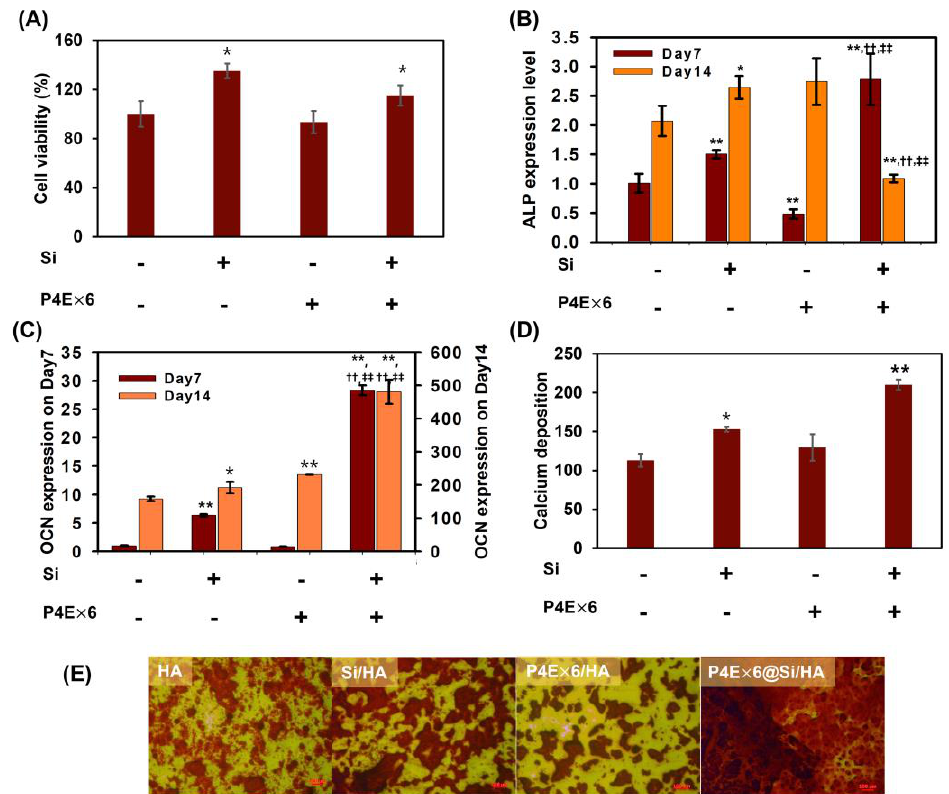
Figure 5. Synergistic effect of P4E × 6 and silica on osteogenesis. ( A ) Cell proliferation of MC3T3 E1 cells on Day 7 after being treated with the indicated HA preparation. The relative cell viability was calculated as the mean fold over that of control without additive, * p < 0.05 vs. control HA without additive. ( B , C ) The mRNA levels of alkaline phosphatase (ALP) ( B ) and osteocalcin (OCN) ( C ) on Day 7 and on Day 14 of MC3T3 E1 cells after treatment with the indicated HA preparation. Statistically significant differences are indicated with * p < 0.05, and ** p < 0.01 vs. control HA without additive of each day, †† p < 0.01 vs. silica-coated HA at each day; and ‡‡ p < 0.01 vs. P4E × 6 adsorbed HA at each day. On Day 21, calcium mineral precipitates stained with Alizarin Red S and area sum of Alizarin-Red S-stained regions by Image J software (NIH, Bethesda, MD, USA) ( D ), * p < 0.05 and ** p < 0.01 vs. control HA without additive. Microscopic image of calcium precipitates stained by Alizarin Red S ( E ). The red scale bar represents 100 μm.